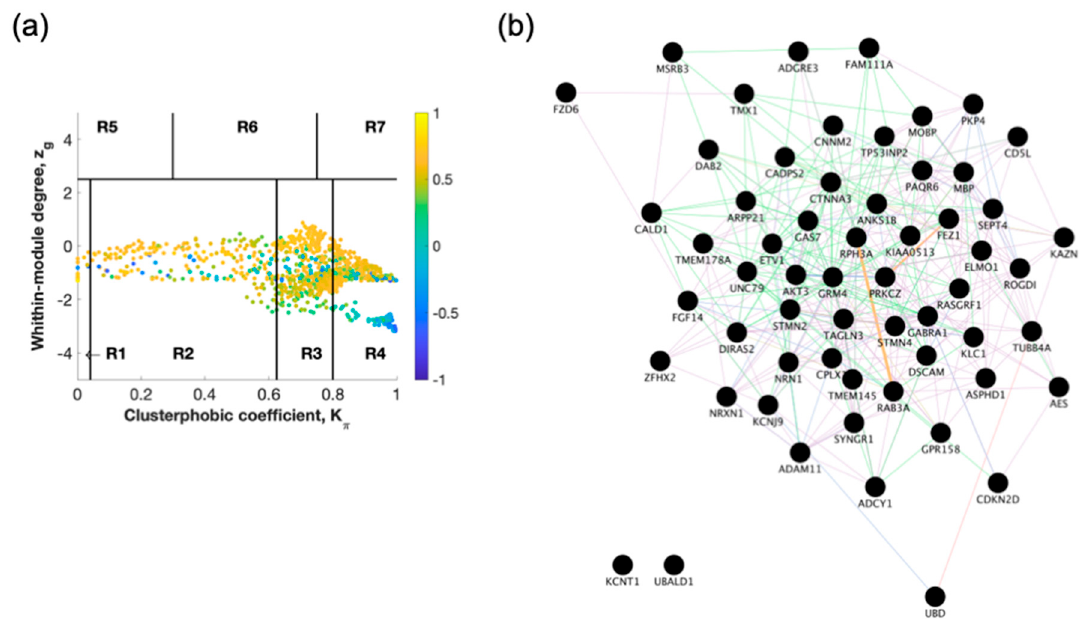
Figure 2. Identification of Alzheimer’s disease (AD) versus healthy switch genes. ( a ) Heat cartography maps of nodes of the AD/healthy correlation networks from the GSE118553 dataset. Dots correspond to nodes in the AD correlation networks and are distributed across seven regions (R1 to R7) according to their clusterphobic coefficient K π ( x -axis) and according to their within-module degree Zg ( y -axis). Region R4 represents the switch with nodes. ( b ) Network analysis. Gene network analysis was performed using GeneMANIA in Cytoscape v3.8.0. Input genes are shown in black circles. Purple, blue, and pink lines represent co-expression, co-localization, and physical interactions, respectively.